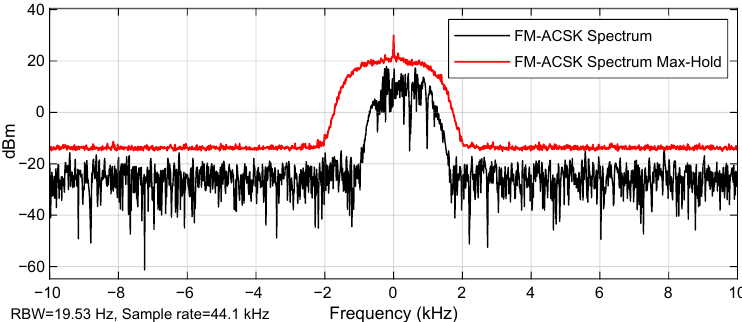
Figure 6. Baseband spectrum of the FM-ACSK at 10 kHz FM deviation.